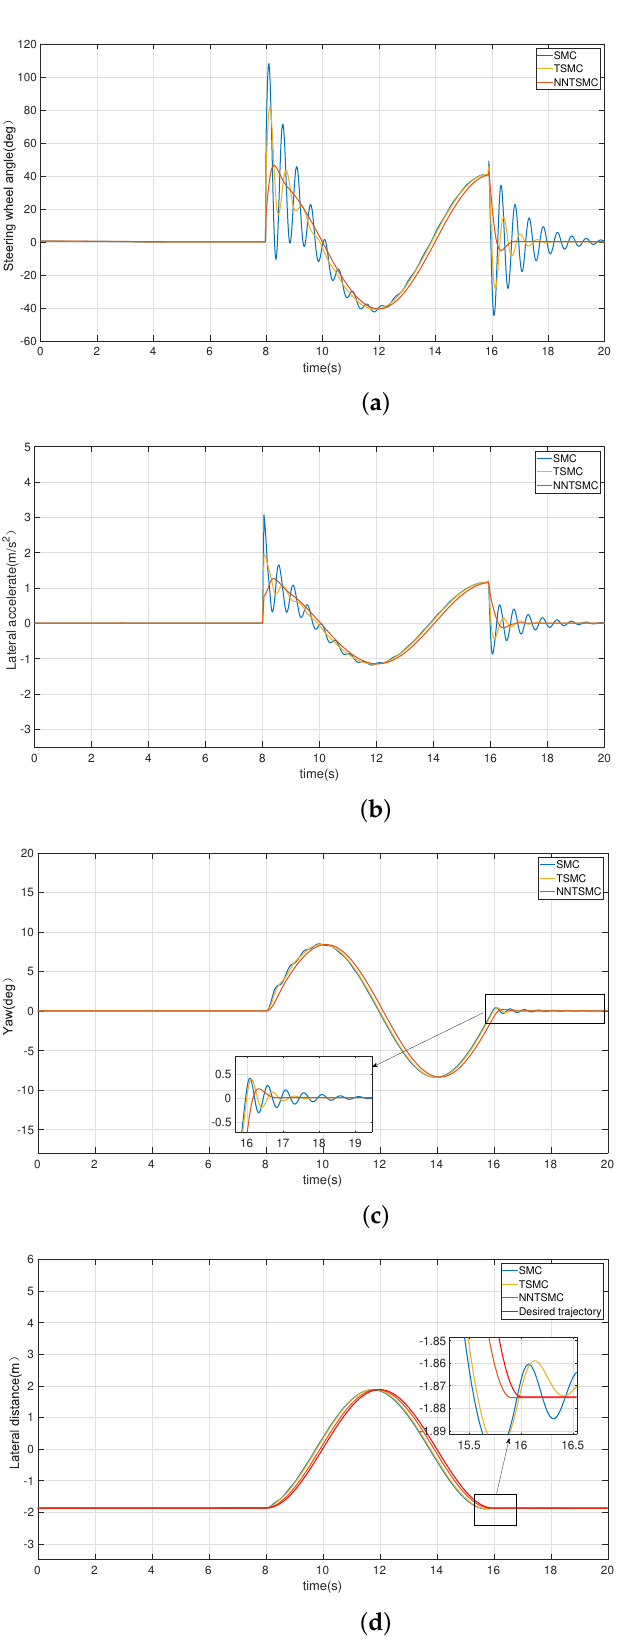
Figure 8. The experimental results of Scenario